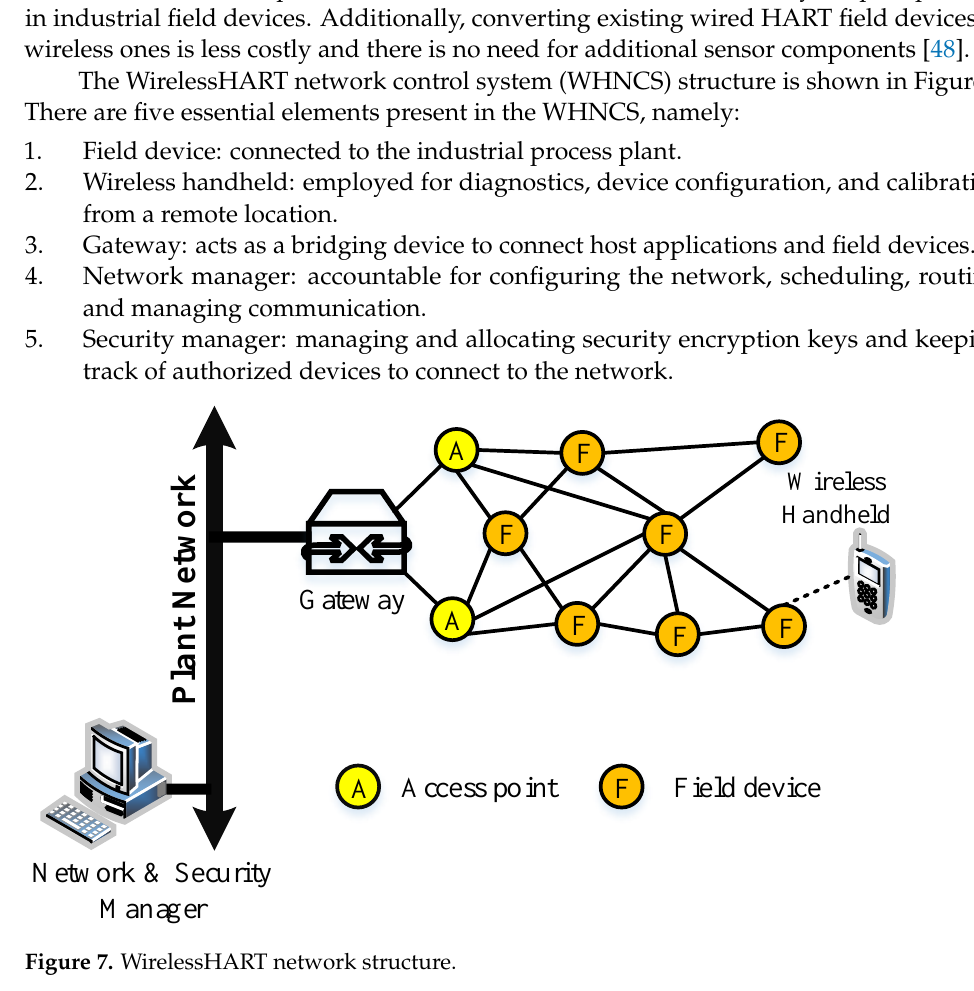
Figure 7. WirelessHART network